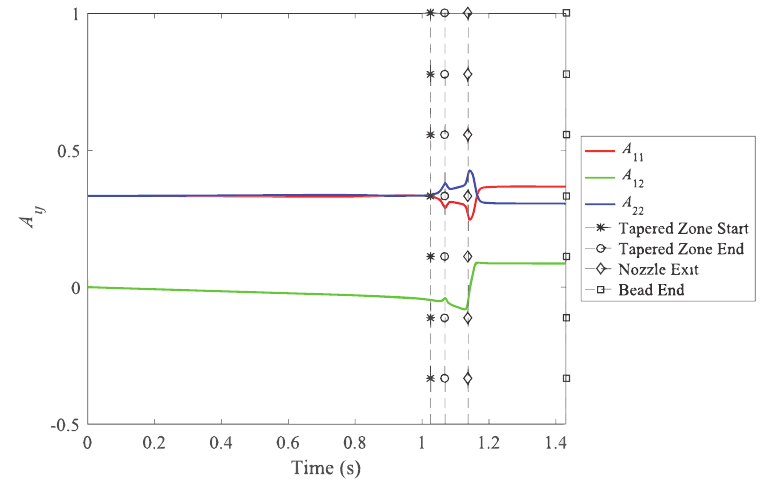
Figure 8. A ij components along streamline 15—results are from using the IRD-RSC model with C I = 10 − 2 and κ =